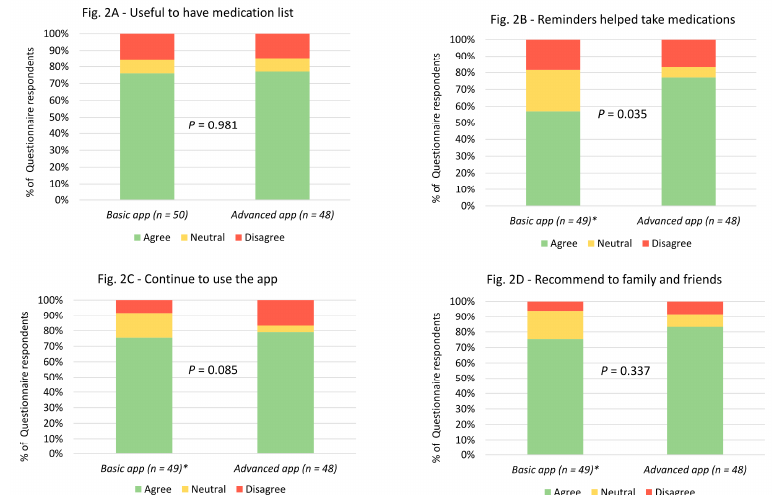
Figure 2. Utility-related questionnaire responses in both basic and advanced app groups. *1 missing response in the basic medication reminder app group.